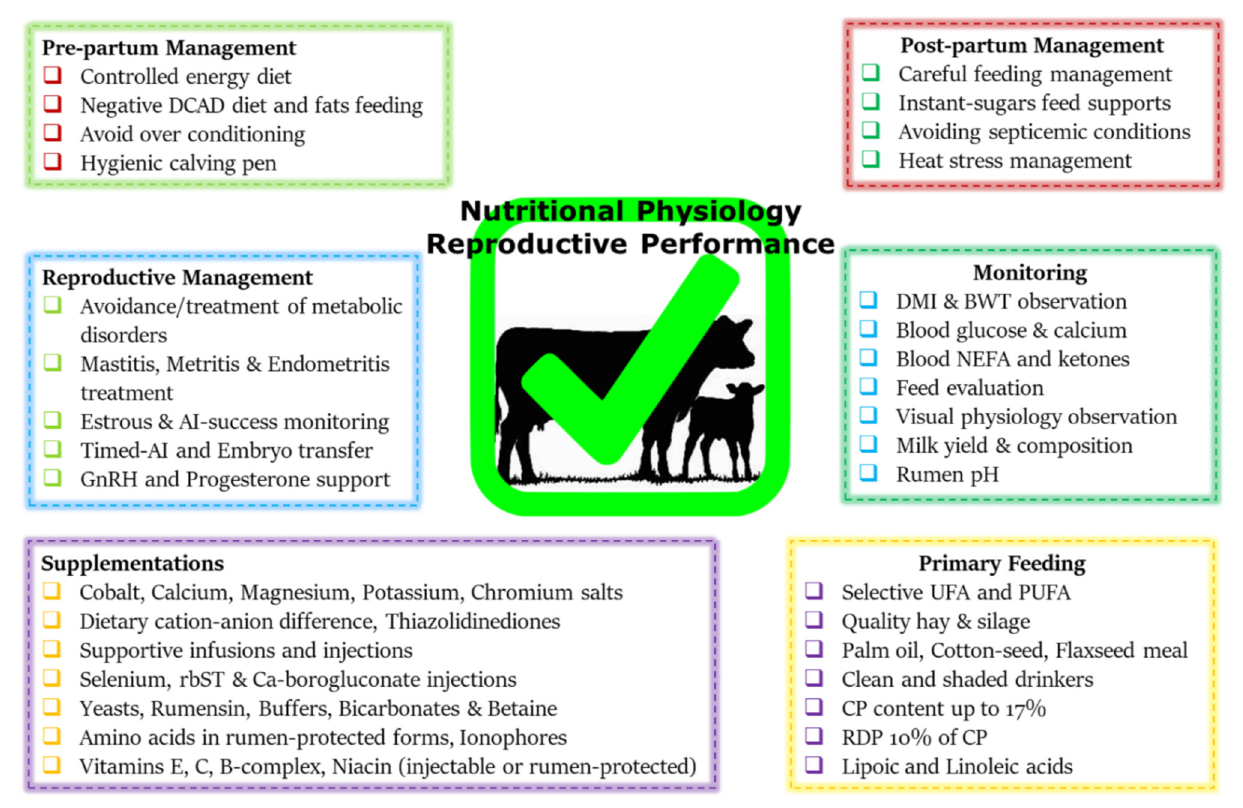
Figure 2. This summary chart encompasses nutritional mitigation and postpartum reproductive management support strategies. Postpartum management should be based upon the advice of dairy extension workers and/or veterinarians, with special care for appropriate feeding practices. (Abbre ‐ viations: DCAD, dietary cation–anion difference; DMI, dry matter intake; BWT, body weight; UFA, unsaturated fatty acid; PUFA, poly ‐ unsaturated fatty acid; CP, crude protein; RDP, rumen ‐ degrada ‐ ble protein; inj., injection; rbST, generic somatotropin; AI, artificial insemination; GnRH, gonadotro ‐ phin.) This figure is based upon the mitigation charts of our previous studies [9,187] and the recom ‐ mendations given in this study.